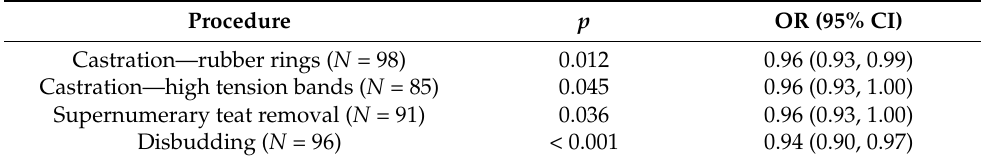
Table 8. A comparison of the impact of number of years since graduation a on the perceived postprocedural pain durations of veterinarians across certain husbandry